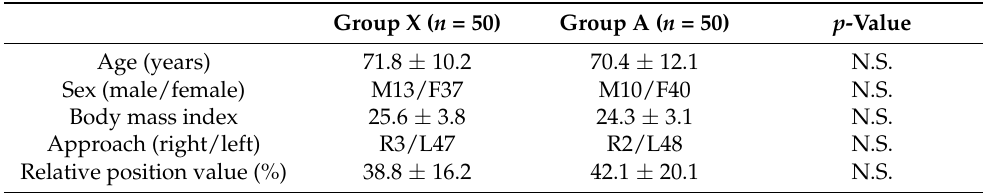
Table 1. Preoperative demographic characteristics of the patients in each group.